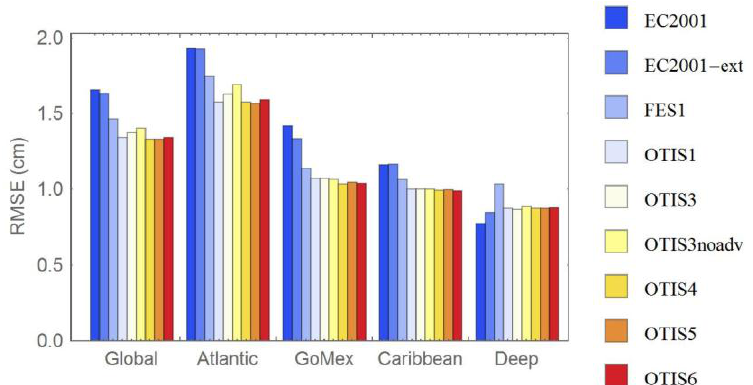
Figure 7. Comparison of regional root mean square (RMS) errors using the 367 wet stations for all nine study simulations summarized in Table 4.